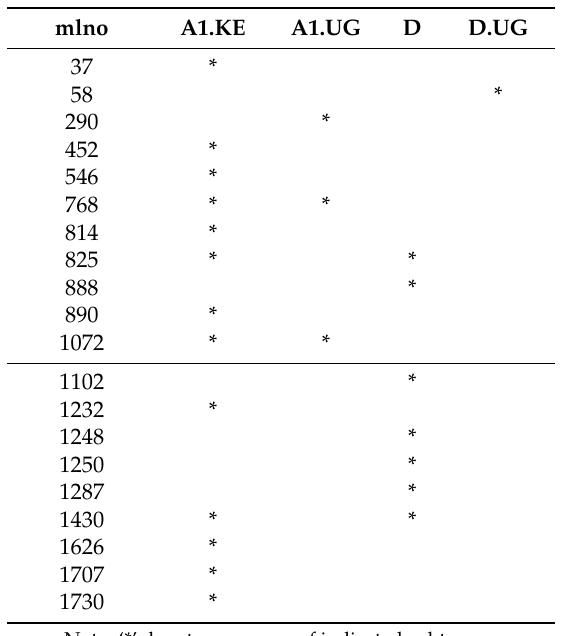
Table 5. HIV-1 subtype classification of 5 (cid:48) LTR-leader variants of viruses infecting late